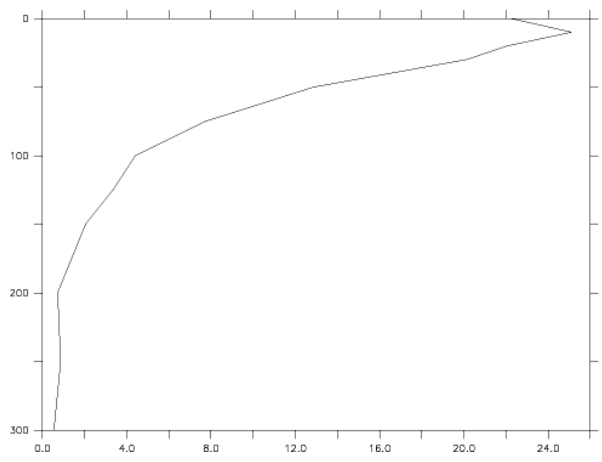
Figure 3. Average picophytoplankton biomass [ µ gCl − 1 ] as a func- tion of depth